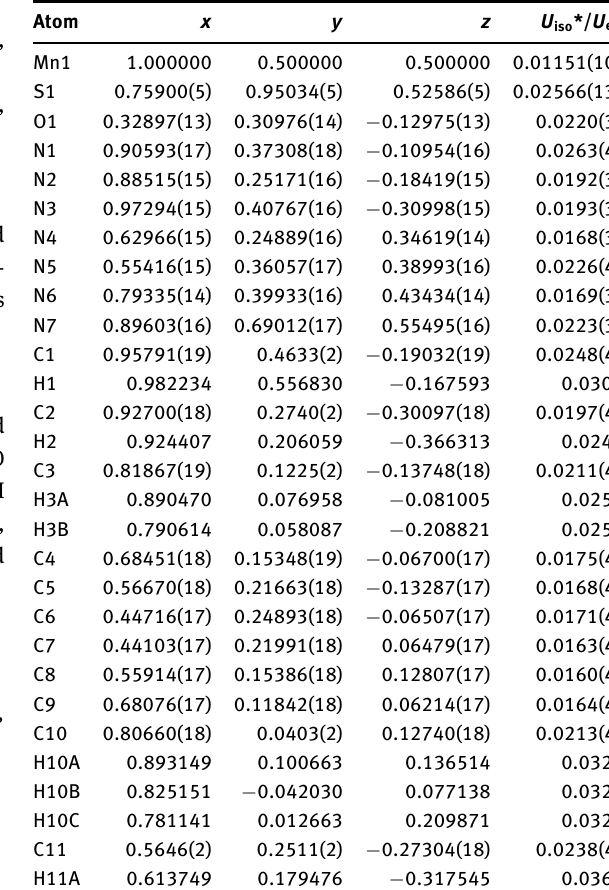
Table 2: Fractional atomic coordinates and isotropic or